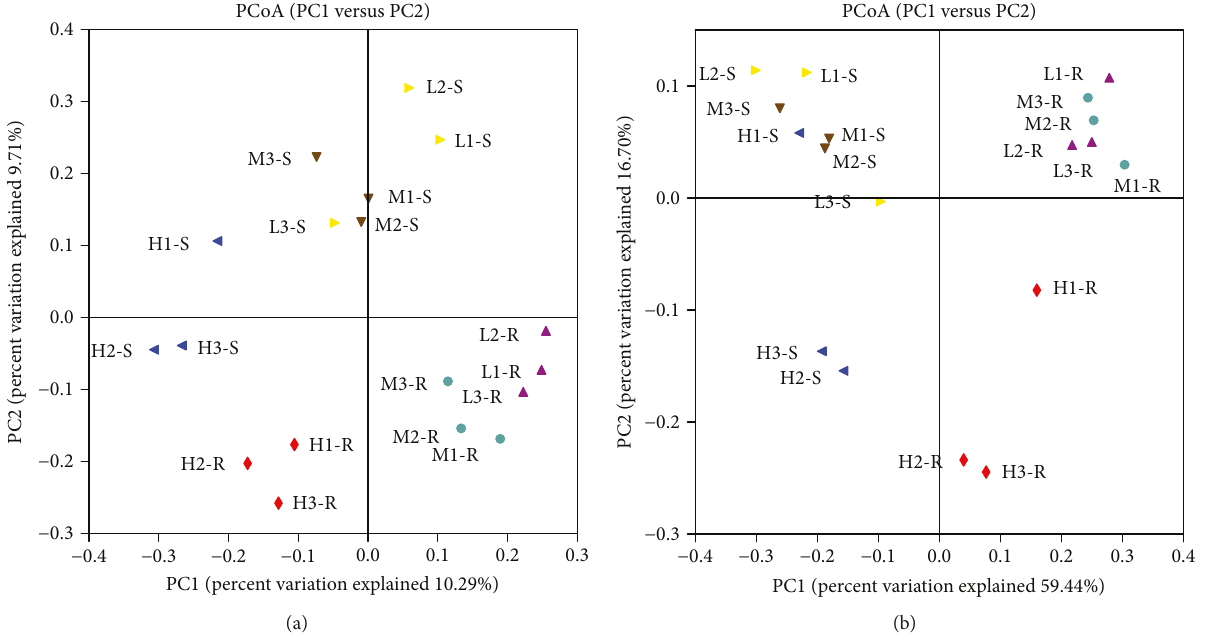
Figure 2: Unweighted (a) and weighted (b) principal coordinate analysis (PCoA) of the R- and S-samples from the three CW groups treating mariculture wastewater with di ff erent TAN